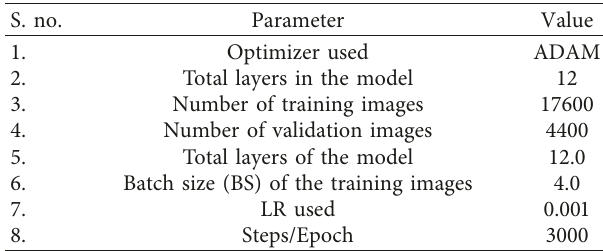
Table 2: Simulation